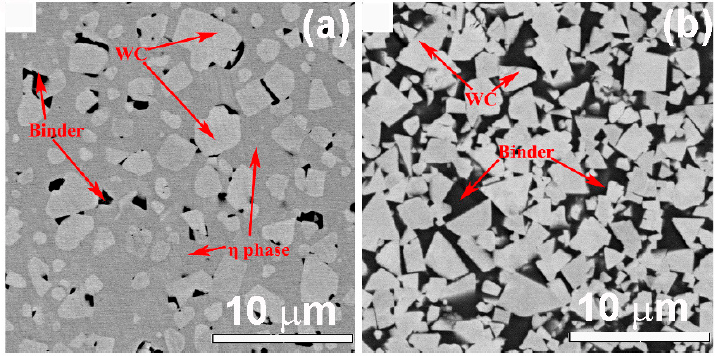
Figure 5. Cemented carbide microstructures indicating WC grains surrounded by the η -phase ( a ) and CoNiFeCrC-based binder ( b ). Reprinted with permission from Ref. [62]. Copyright 2022 Else- vier.